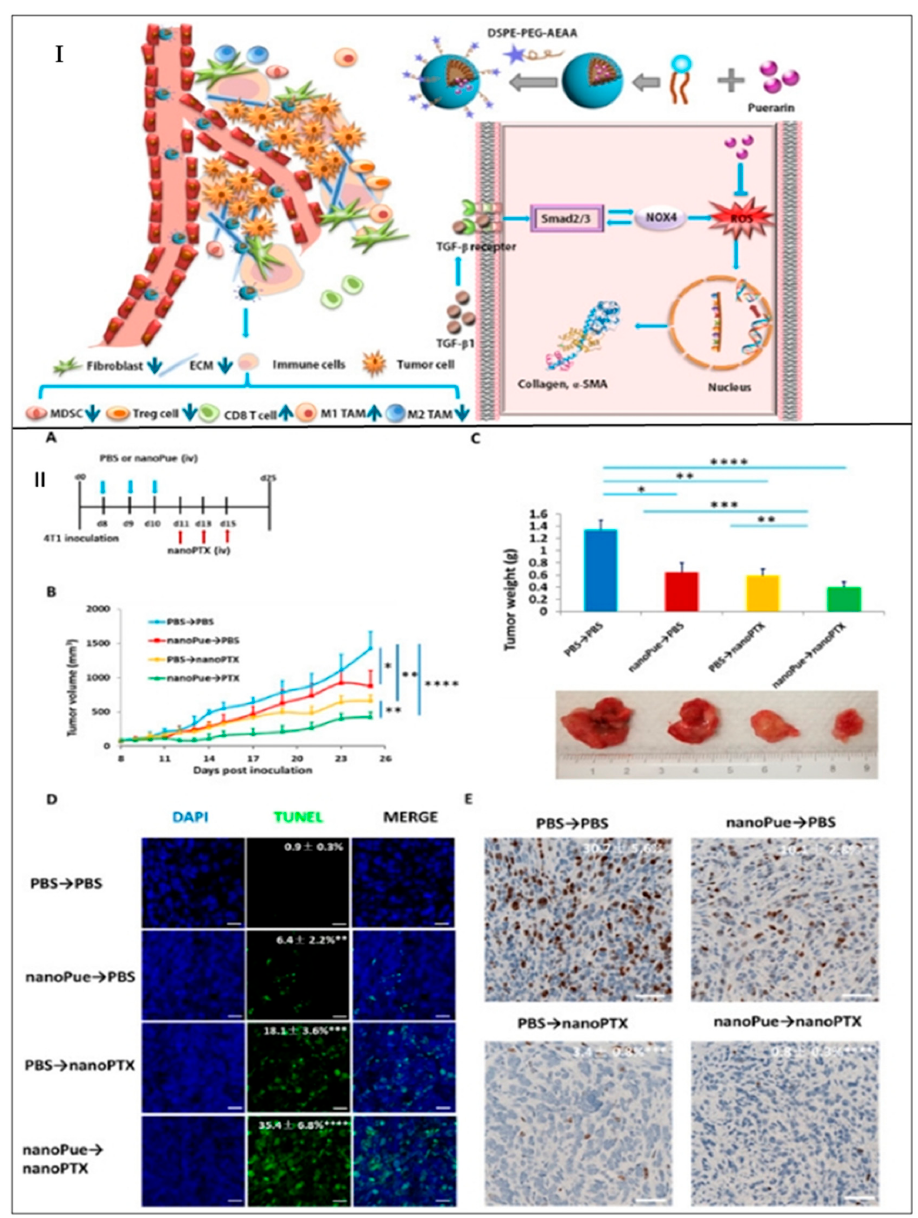
Figure 4. ( I ) Schematic diagram of TME remodulation by targeted delivery of puerarin-loaded nanoemulsion. ( II ) Combination treatment of nanoPue and nanoPTX on 4T1 tumor model: ( A ) nanoPue and nanoPTX combination treatment scheme. ( B ) Tumor growth curves of 4T1 tumors in different treatment groups. ( C ) The tumor weight and the representative tumor image at the end of the experiment in different treatment groups. ( D ) TUNEL staining of differently treated 4T1 tumor tissues. ( E ) Comparison of Ki67 expression of 4T1 tumors in different treatment groups. Scale bar